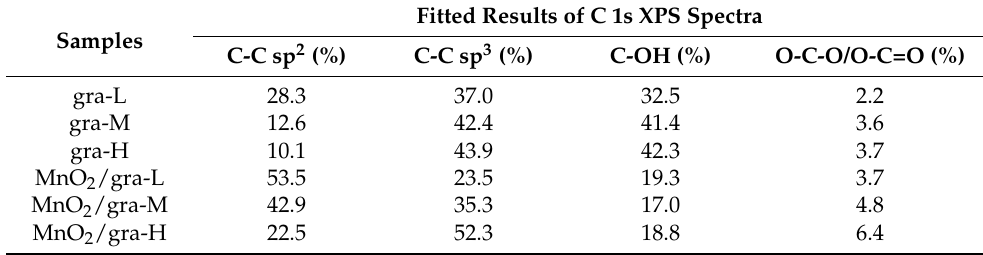
Table 1. Fitted results of C 1s XPS spectra.